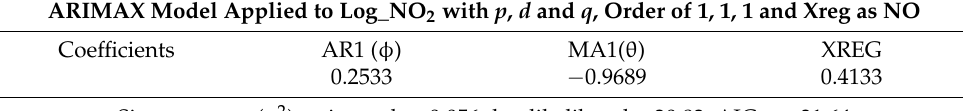
Table 5. Estimating the parameters of the ARIMAX (1,1,1) model for the NO 2 concentrations ( µ g/m 3 ) training dataset, with NO as exogenous variable.